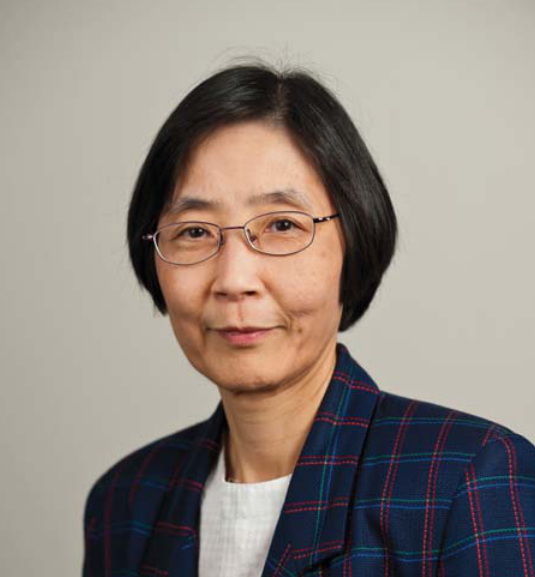
Figure 1. Anna Suk-Fong Lok, MD,